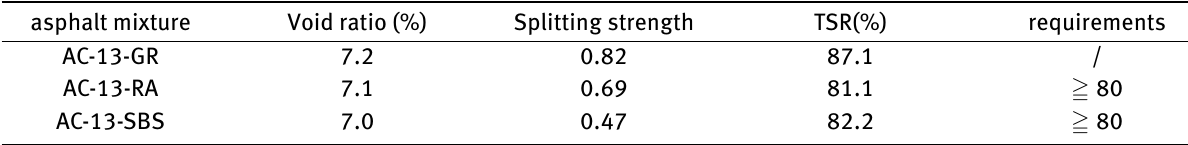
Table 7: Water stability test of GORA mixture asphalt